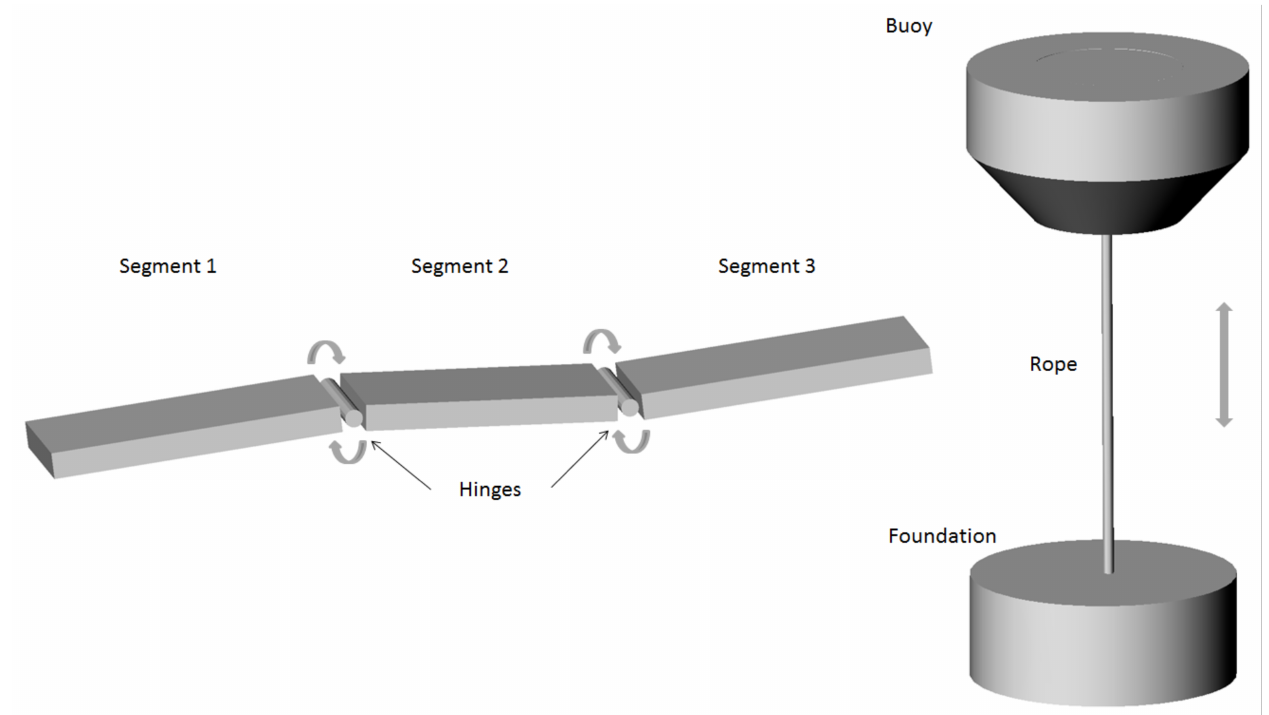
Figure 1. Schematic diagram of an attenuator ( left ) and point absorber ( right )